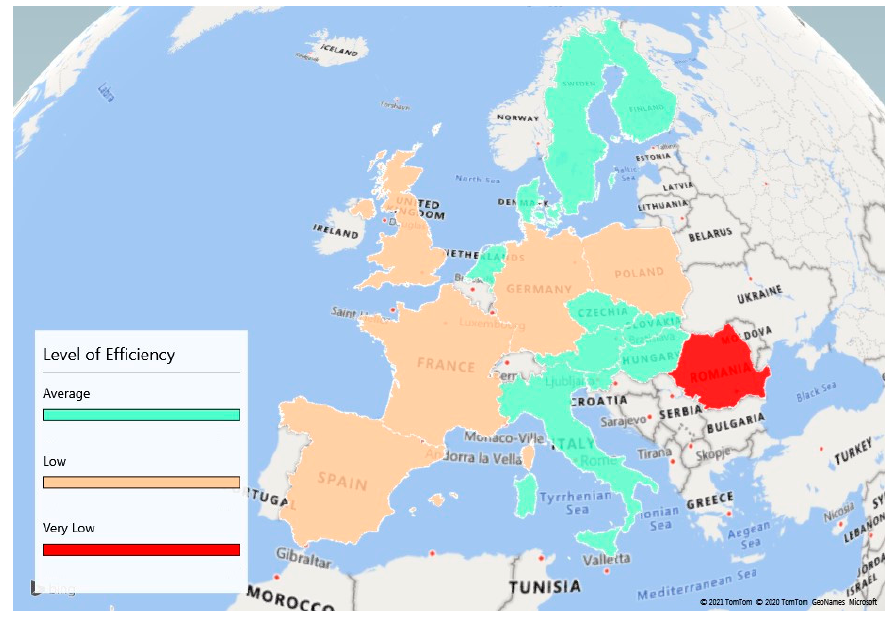
Figure 3. Map of countries based on efficiency level in the bioenergy field. Source: authors.